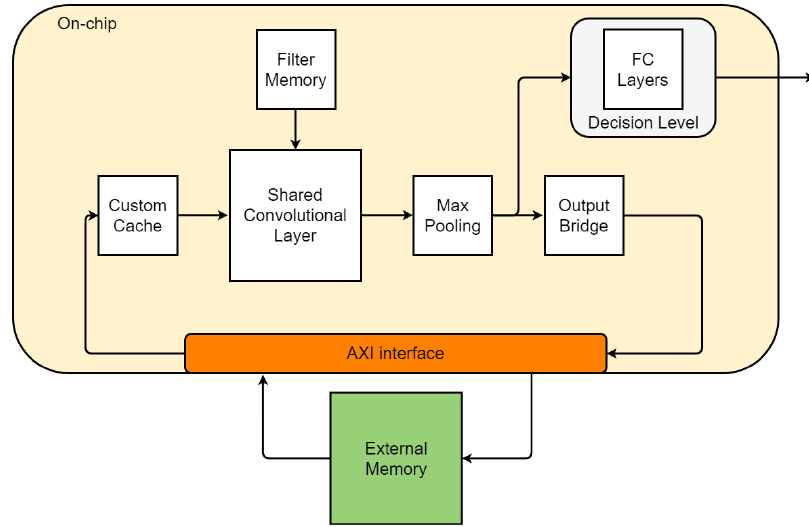
Figure 2. CloudScout Hardware Accelerator